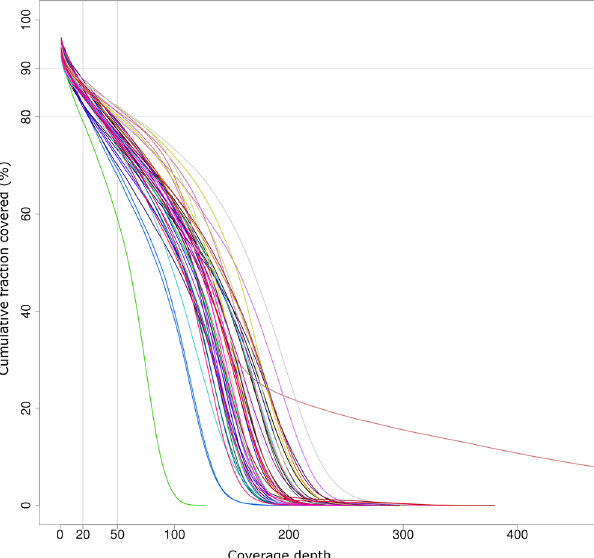
Figure 2. Cumulative distribution of coverage depth across target regions in 47 tomato genotypes. The box in the graph highlights the fraction of bases captured in the target regions covered at a depth between